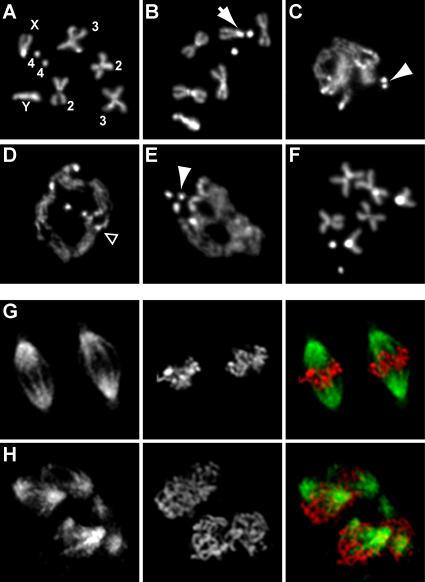
ISWI Regulates Chromosome Structure in Diploid Cells(A–F) Metaphase chromosome spreads isolated from neuroblasts of third-instar larvae grown at 18 °C. (A) Wild-type male metaphase chromosomes. (B) Metaphase chromosomes isolated from male Iswi1/Iswi2 mutant larvae show normal condensation of the X chromosome (arrow). By contrast, mitotic chromosomes (C–E) of larval neuroblasts producing dominant-negative ISWI (ISWIK159R) appear much less condensed than normal. In these chromosomes, euchromatin is highly decondensed, whereas heterochromatic regions, such as centromeres (open arrowhead in [D]) and the fourth chromosomes (arrowheads in [C] and [E]), appear to condense normally. The production of dominant-negative BRM (BRMK804R) does not alter the morphology of mitotic chromosomes (F).(G and H) Nuclear cycle 12 embryos grown at 25 °C were stained for α-tubulin (green) and DAPI (red). Metaphase chromosomes in control +; da-GAL4/T(2;3)B3 CyO, TM6B, Tb embryos (G) appear normally condensed, while Iswi2/+; UAS-IswiK159R/da-GAL4 embryos (H) show abnormal chromosome morphology and spindle formation.